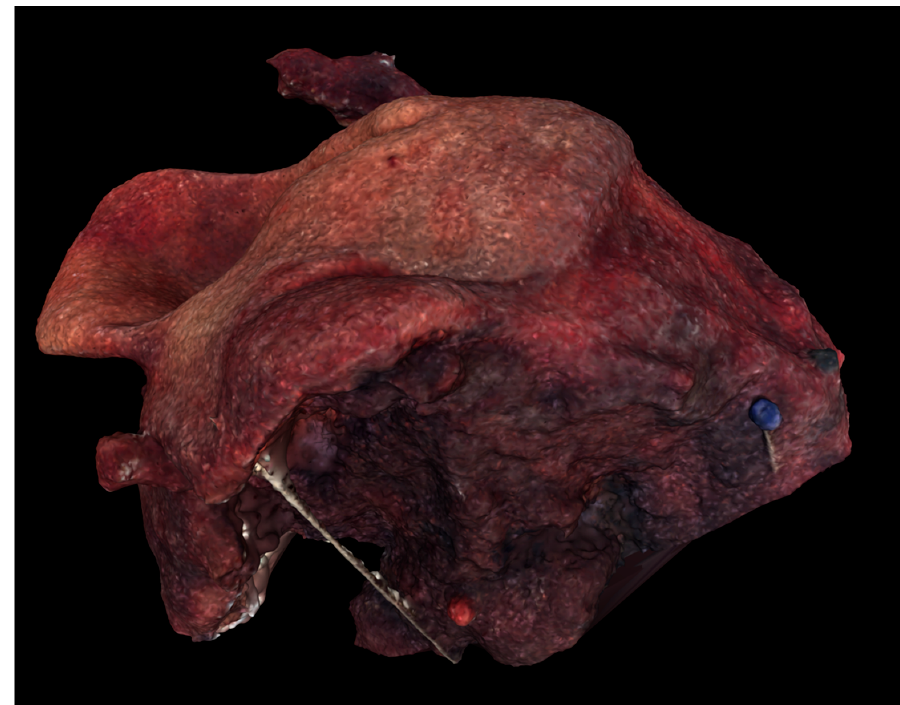
Figure 6. Digital 3D model of Case 3 using Meshlab.